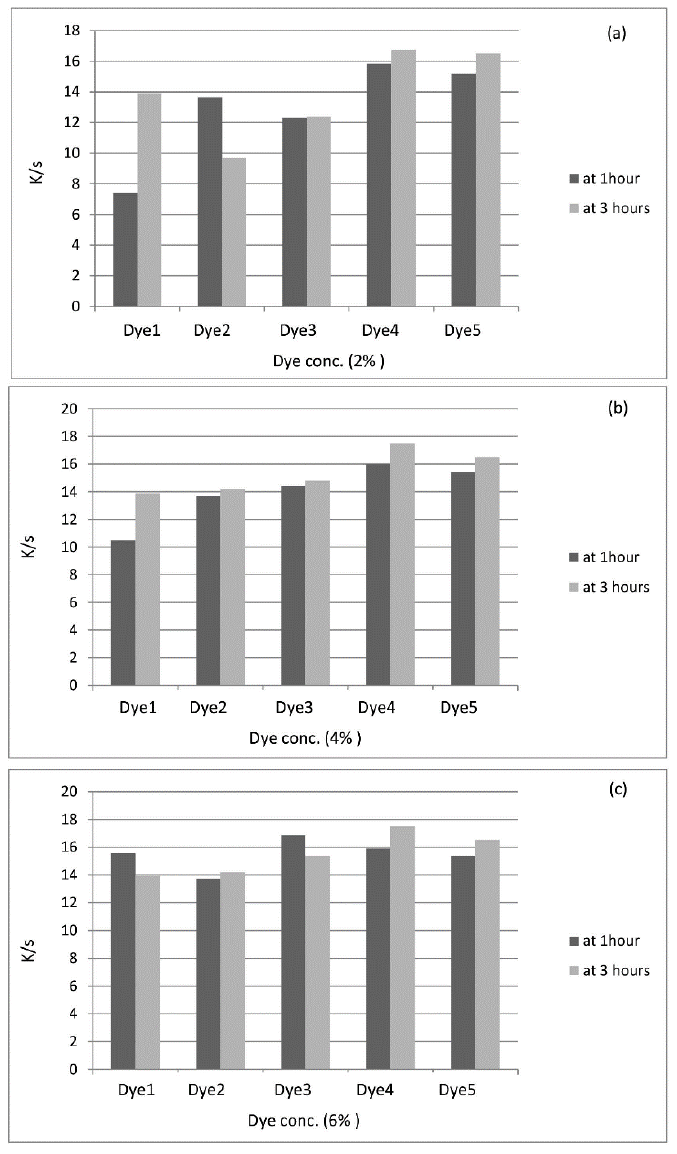
Figure 7. ( a ) Effect of dyeing time at 2% dye conc; ( b ) at 4% dye conc; ( c ) at 6% dye